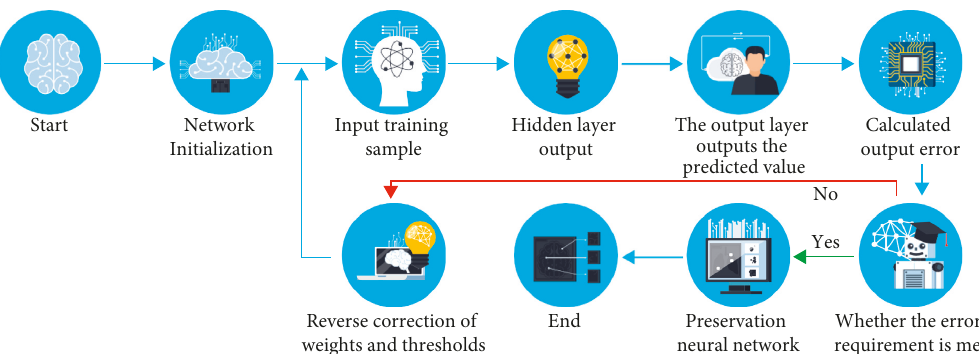
Figure 2: Flowchart of the BP neural network